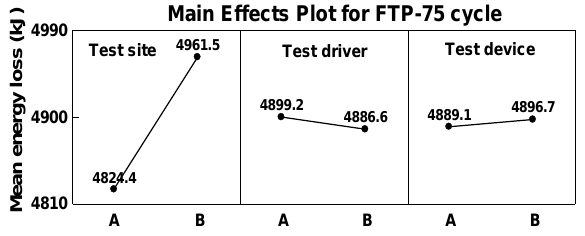
Figure 8. Main effects plot for the FTP-75 test cycle.